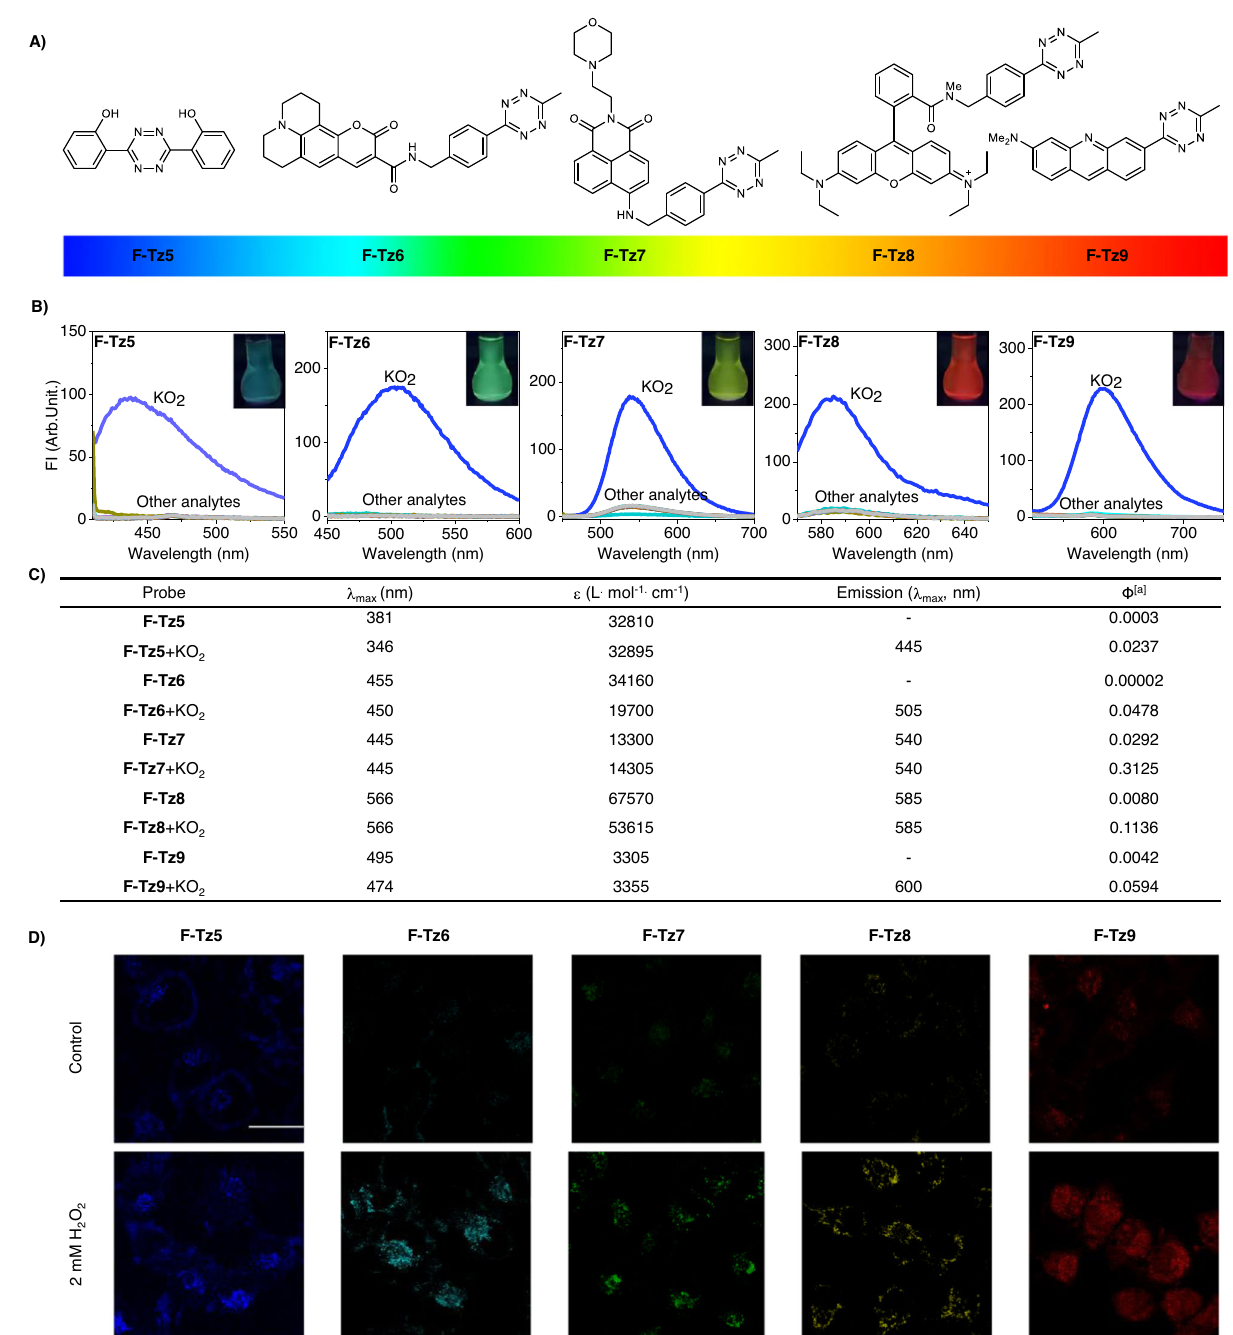
Fig. 4 | Extension of Tz to other fl uorophores to tune probe emission spectra. A Structures of the Tz-tethered probes. B Fluorescence spectra of the probes before or after the treatment of various analytes. C Photophysical properties of the probesbefore or after the treatment of superoxide. [a] Ф : Quantum yields of F- Tz5/6 were determined at an excitation wavelength of 365nm and using quinine sulfate ( Ф standard = 0.577 in 0.1M H 2 SO 4 ) as a standard. Quantum yields of F-Tz7